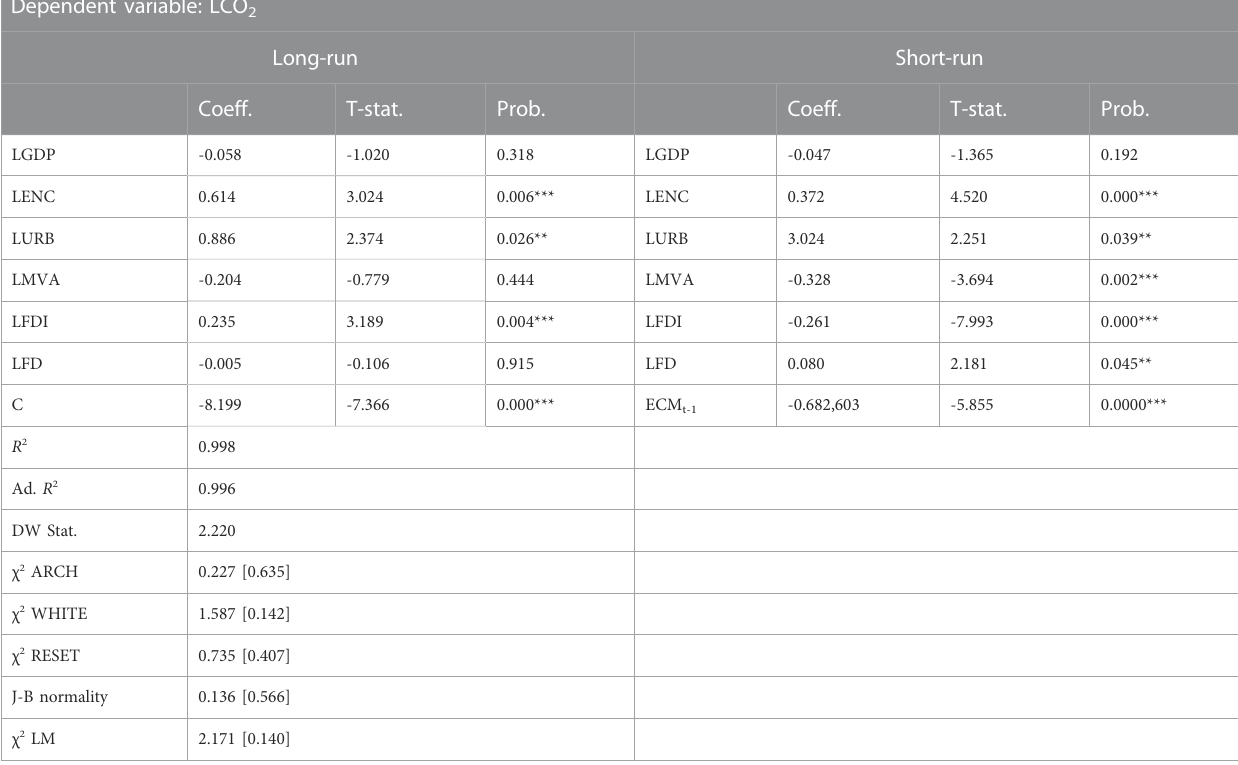
TABLE 7 Short and long-run results of the ARDL estimation.